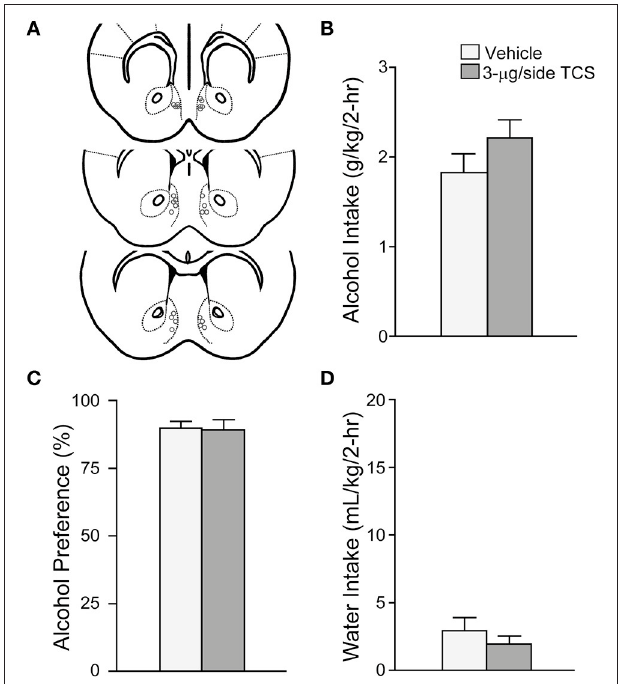
FIGURE 4 | OX1R blockade at an off-site control above the mNAsh did not alter alcohol drinking. (A) Locations of cannulae, as for Figure 1 . (B–D) Infusion of 3- µ g SB ∼ 1.5mM above the mNAsh did not alter (B) alcohol intake, (C) preference, or (D) concurrent water intake.